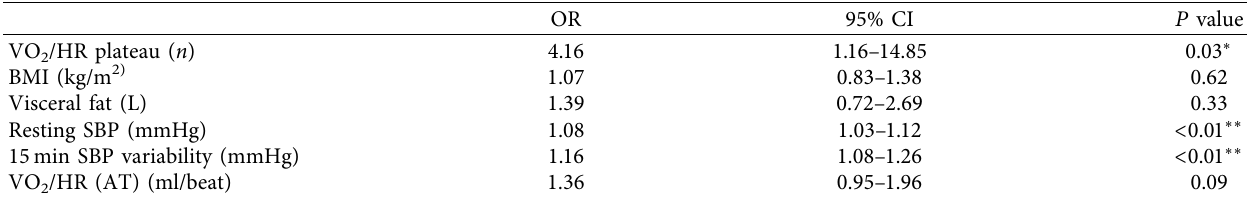
Table 3: Binary logistic regression analysis of EH in hypertensive patients during exercise.